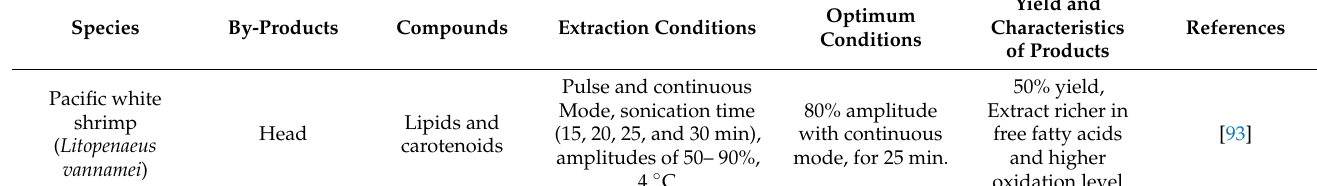
Yield and Optimum Characteristics Conditions of